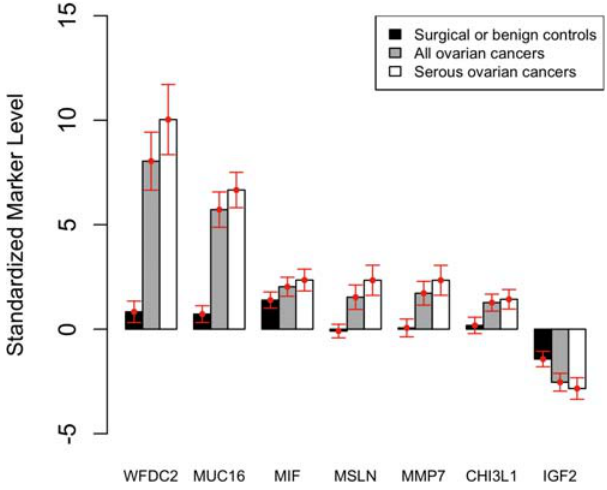
Figure 1. Normalized serum marker levels. Bar heights indicate the mean of the normalized values of a given marker in the specified subset of cases or controls. Error bars represent the 95% confidence interval associated with the mean. The logarithm of serum marker concentrations were normalized to standard deviations from the mean of the corresponding measurements in Healthy Controls.